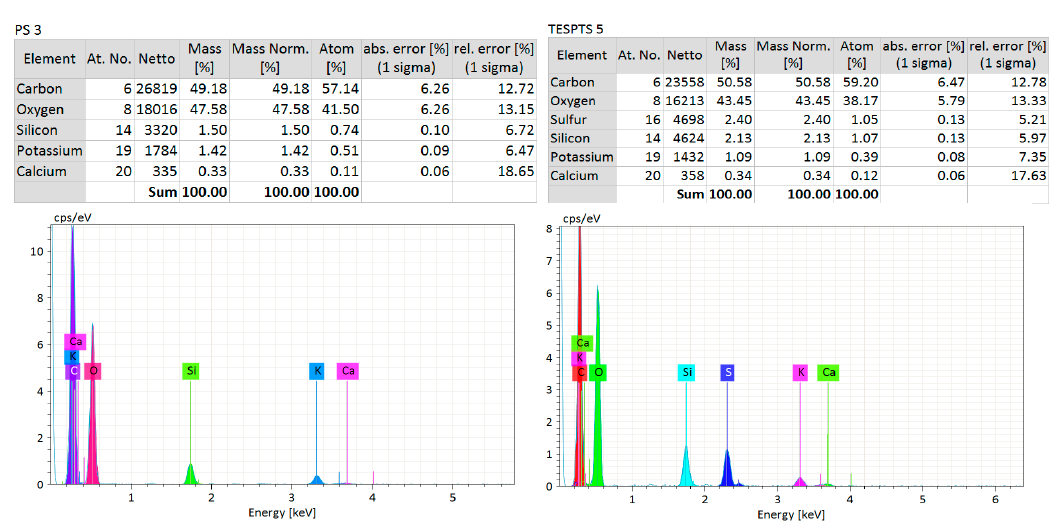
Figure 9. Tear resistance of natural rubber composites containing modified and unmodified straw.